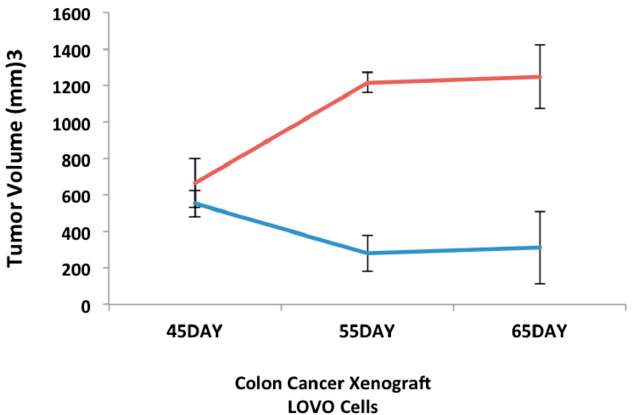
Figure 6. Graph showing tumor growth record of LOVO (colon cancer xenograft) in untreated mice group ( red line ) and DHP-5 –treated (50 mg/kg) mice group ( blue line ).